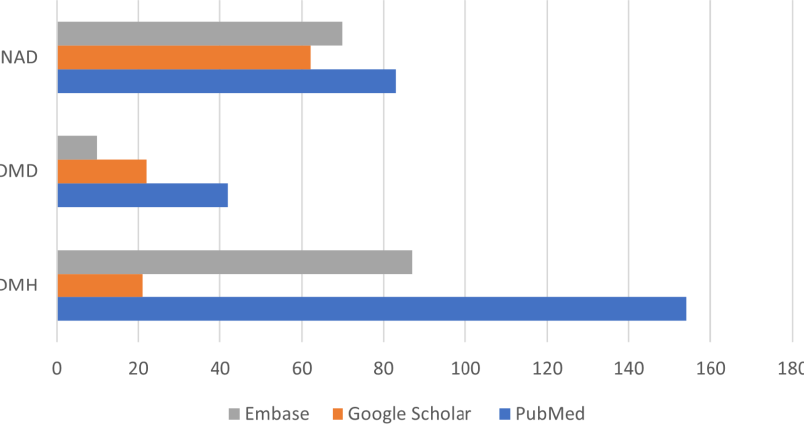
Figure 2. Number of studies identified in the three databases and allocated into three categories.